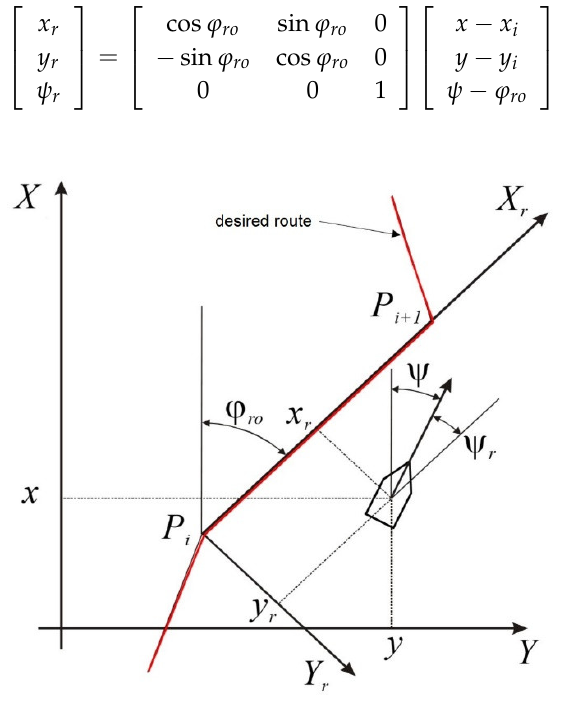
Figure 2. Global and relative reference systems.